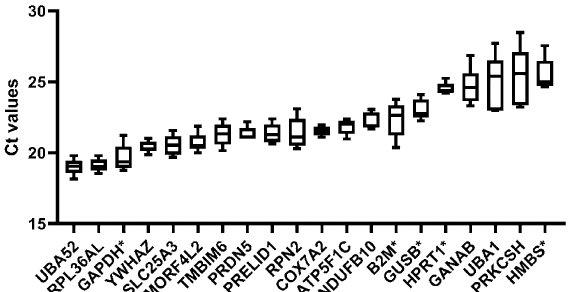
Figure 1. Mean Ct values. Mean Ct values of iPSC WT , iPSCS SERPINE1-FOSB , iPSC-EC WT of each housekeeping gene were shown in a box-and-whisker plot and sorted from the lowest (left) to the highest (right). The five added common housekeeping genes are denoted with an asterisk. The whiskers represent SD of nine samples, three samples per cell line (iPSC WT , iPSCS SERPINE1-FOSB , and iPSC-EC WT ).